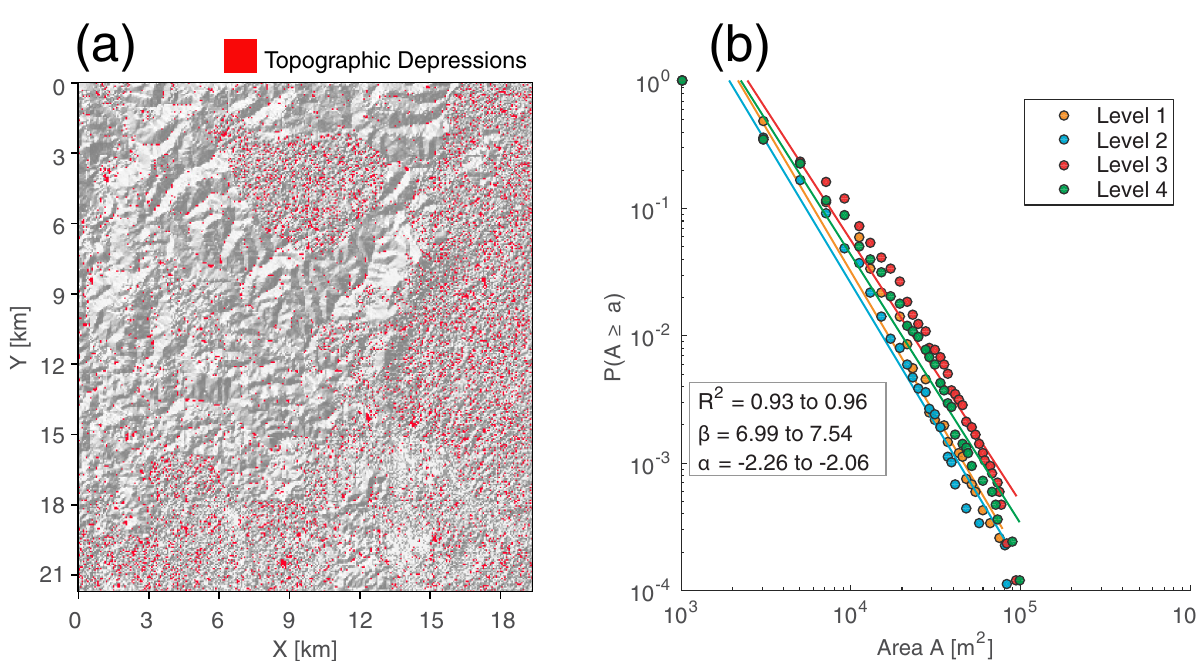
Fig 4. Estimation of power-law scaling of topographic depression. (a) Map of topographic depression (red polygons) identified from digital elevation model using TDI model [64]. The gray background represents hillshaded topography. (b) Scaling law relationship of topographic depressions at different ponding levels. Lines are fitted to the distributions using least square linear regression. R 2 , α , β represent the coefficient of determination, intercept, and slope, respectively, for each curve.